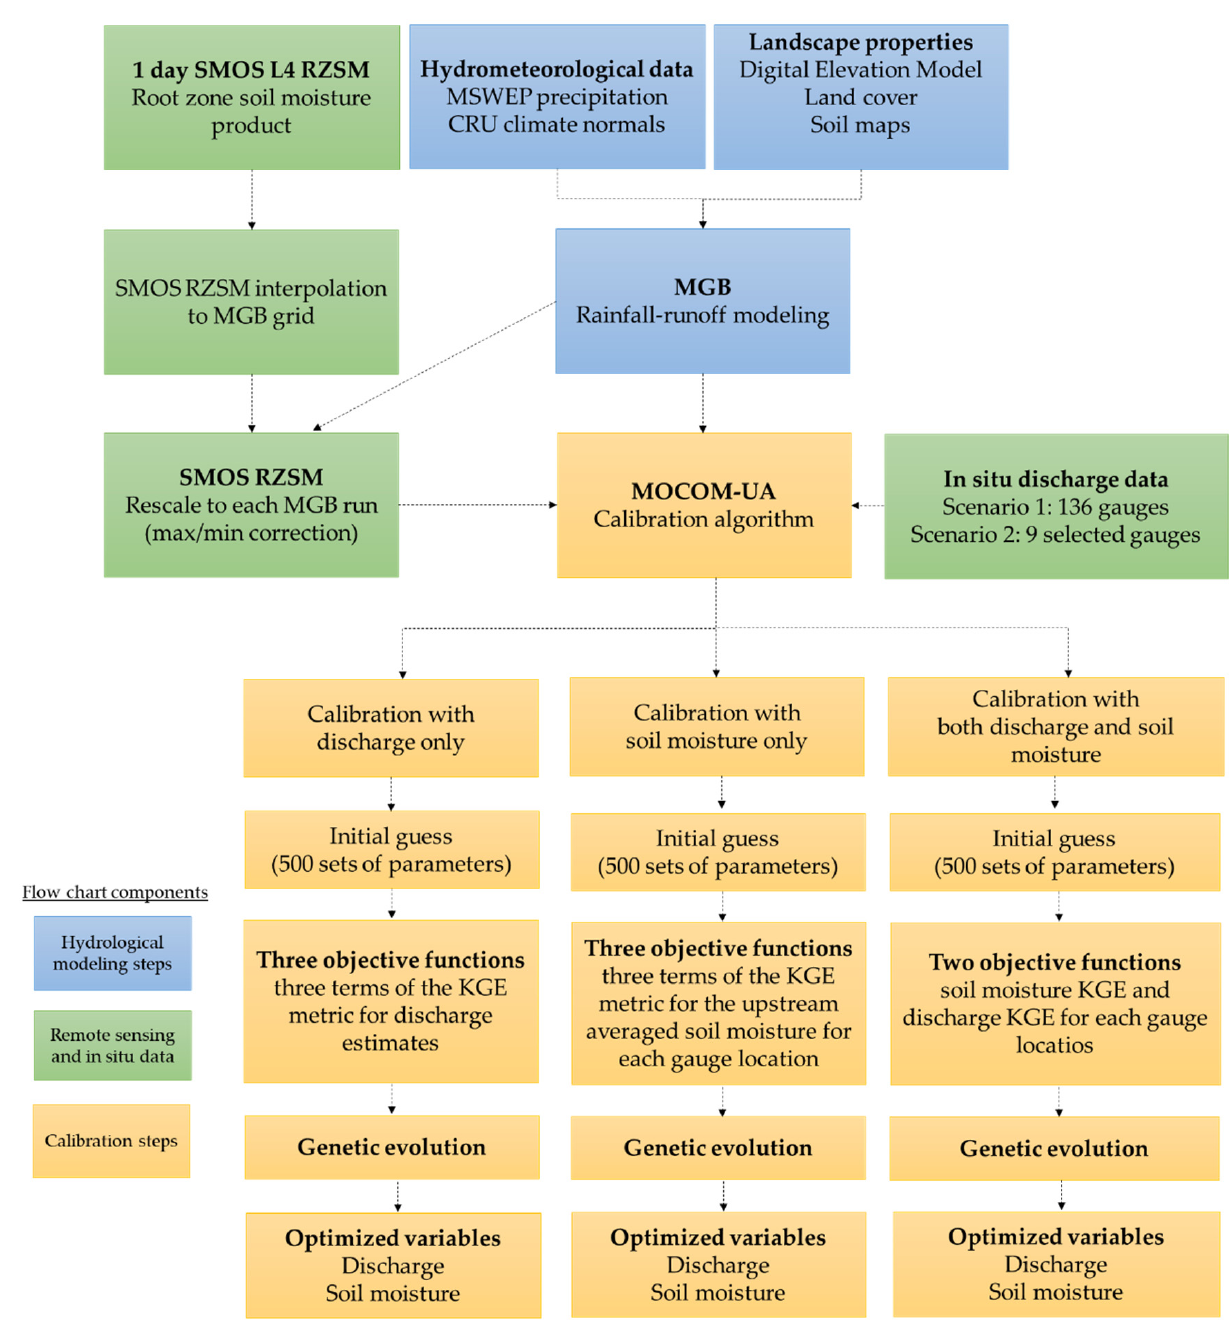
Figure 1. Flow chart of the study methodology.